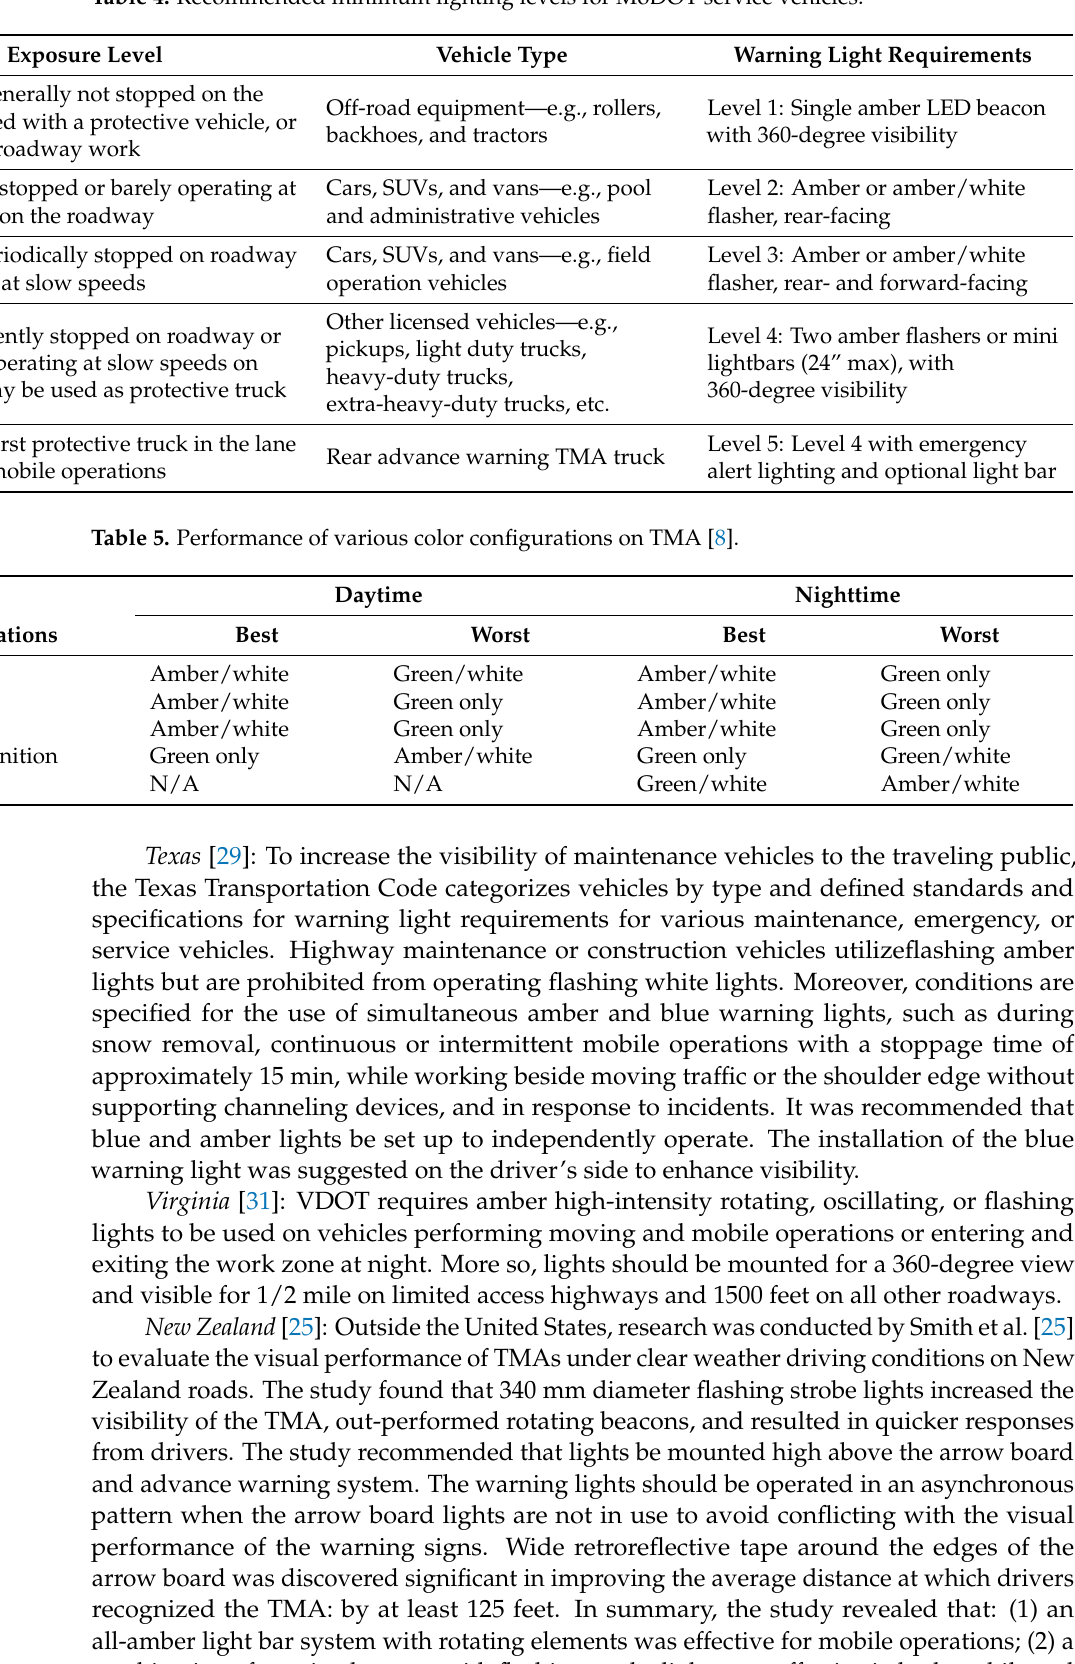
Table 4. Recommended minimum lighting levels for MoDOT service vehicles.